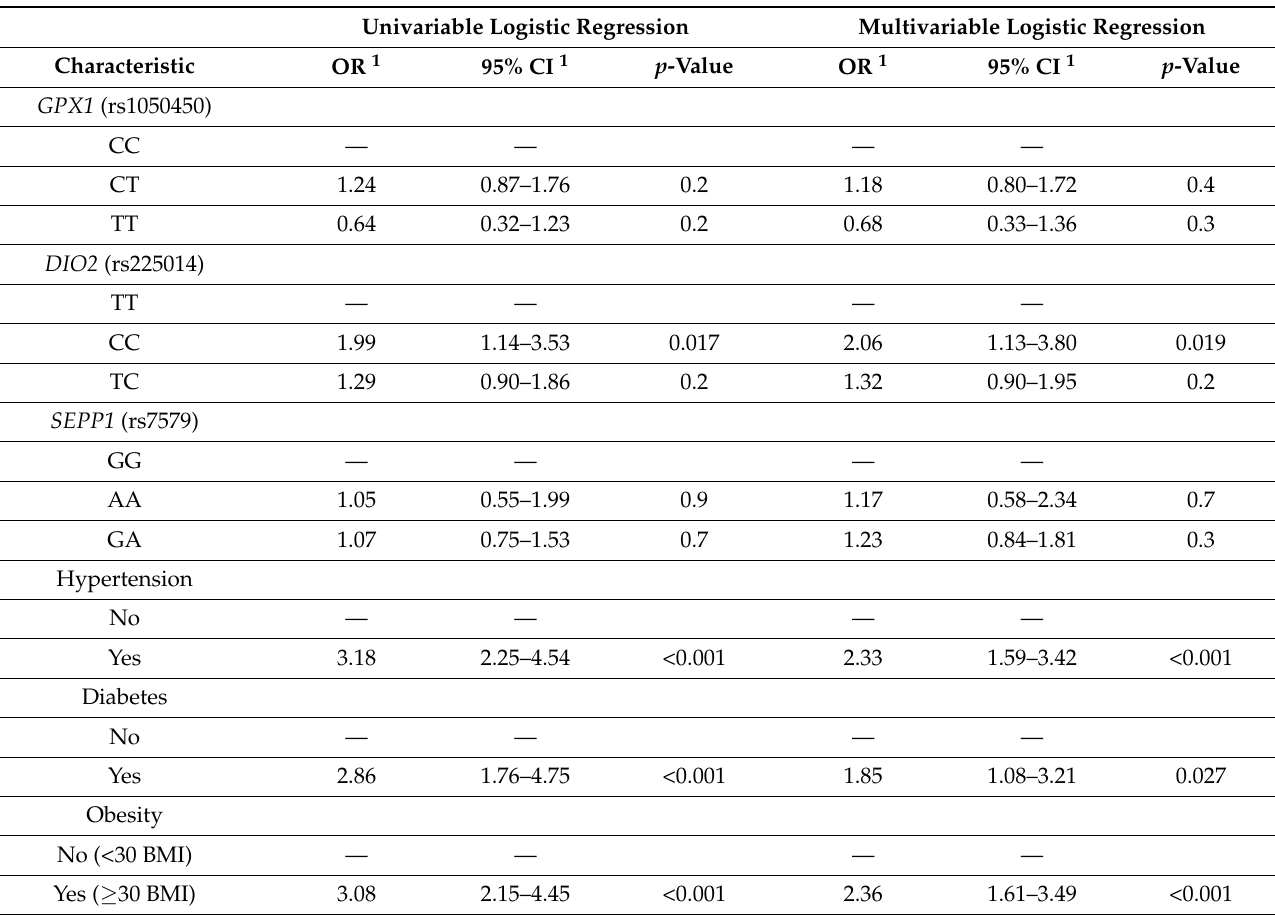
Table 2. Univariate and multivariate analysis of selected polymorphisms and endometrial cancer risk factors. Univariable Logistic Regression Multivariable Logistic